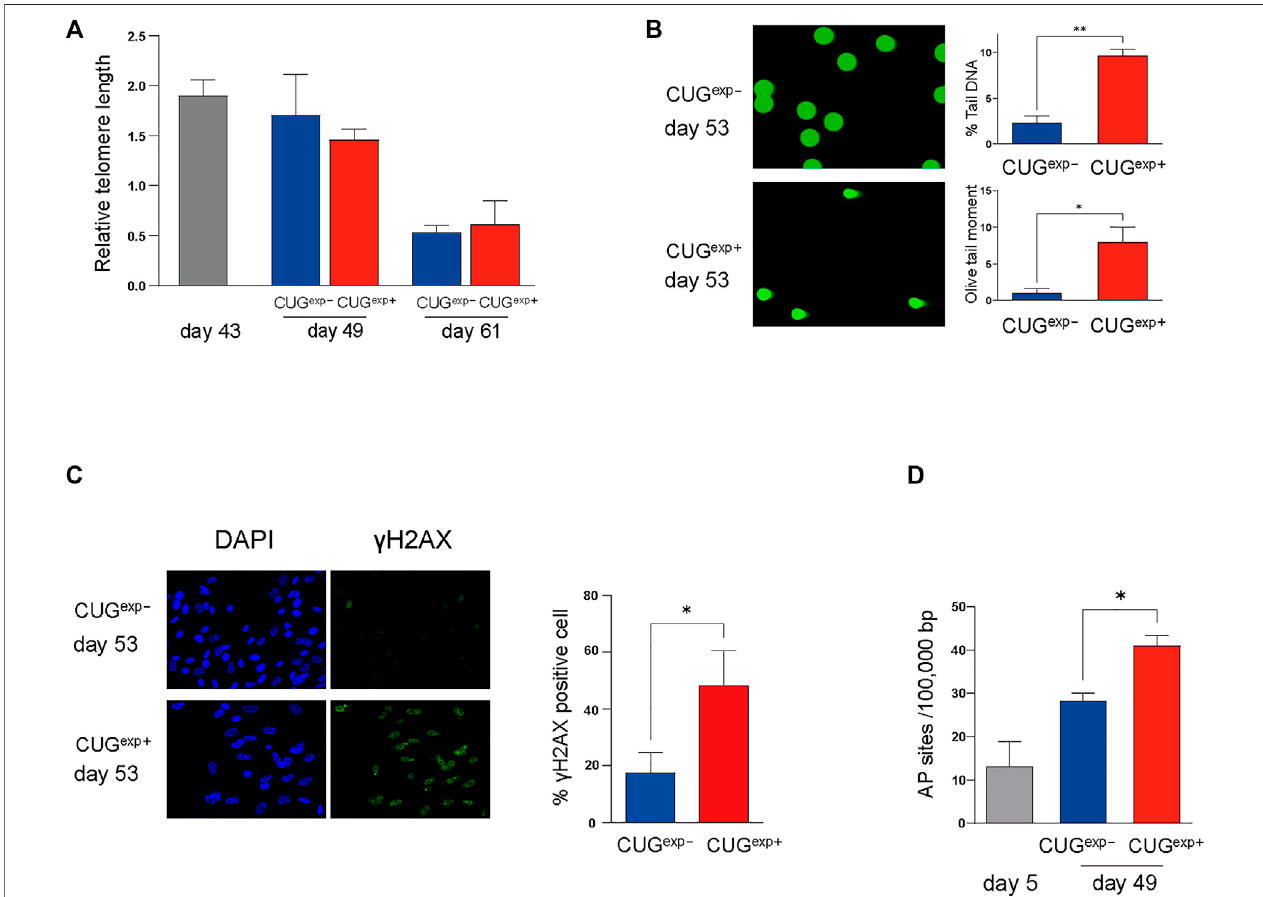
FIGURE4| ExpandedCUGrepeatRNAcausesDNAdamageinatelomere-independentmanner. (A) MeasurementofrelativetelomerelengthbyqPCR.Telomere lengthwasmeasuredatthreedifferentstages(atdays43,49,and61)incellsnotexpressingCUG exp (CUG exp − )(blue)andcellsexpressingCUG exp (CUG exp+ )(red).Data are presented as means ± SD of three independent experiments. (B) Representative images of DNA damage in comet assays at day 53 (left). DNA damage was evaluatedaccordingtothepercentagetailDNAandOlivetailmoment(right).Dataarepresentedasmeans±SDofthreeindependentexperiments.* p < 0.01,** p < 0.001. (C) RepresentativeimagesofDNAdamagein γ -H2AXassaysatday53(left).Bargraphshowingpercentageof γ -H2AXpositivecells(right).Dataarepresentedas means ± SD of three independent experiments. * p < 0.05. (D) Quanti fi cation of DNA damage response by AP site measurement. The AP site lesions per 100,000 base pairs were measured in the cells before transfection (day 5) and at day 49 in cells not expressing CUG exp (CUG exp − ) and cells expressing CUG exp (CUG exp+ ). Data are presented as means ± SD of three independent experiments. * p < 0.01.